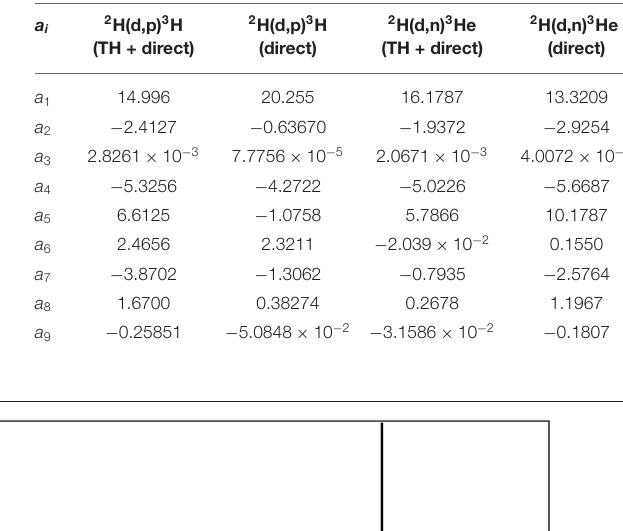
Frontiers in Astronomy and Space Sciences |